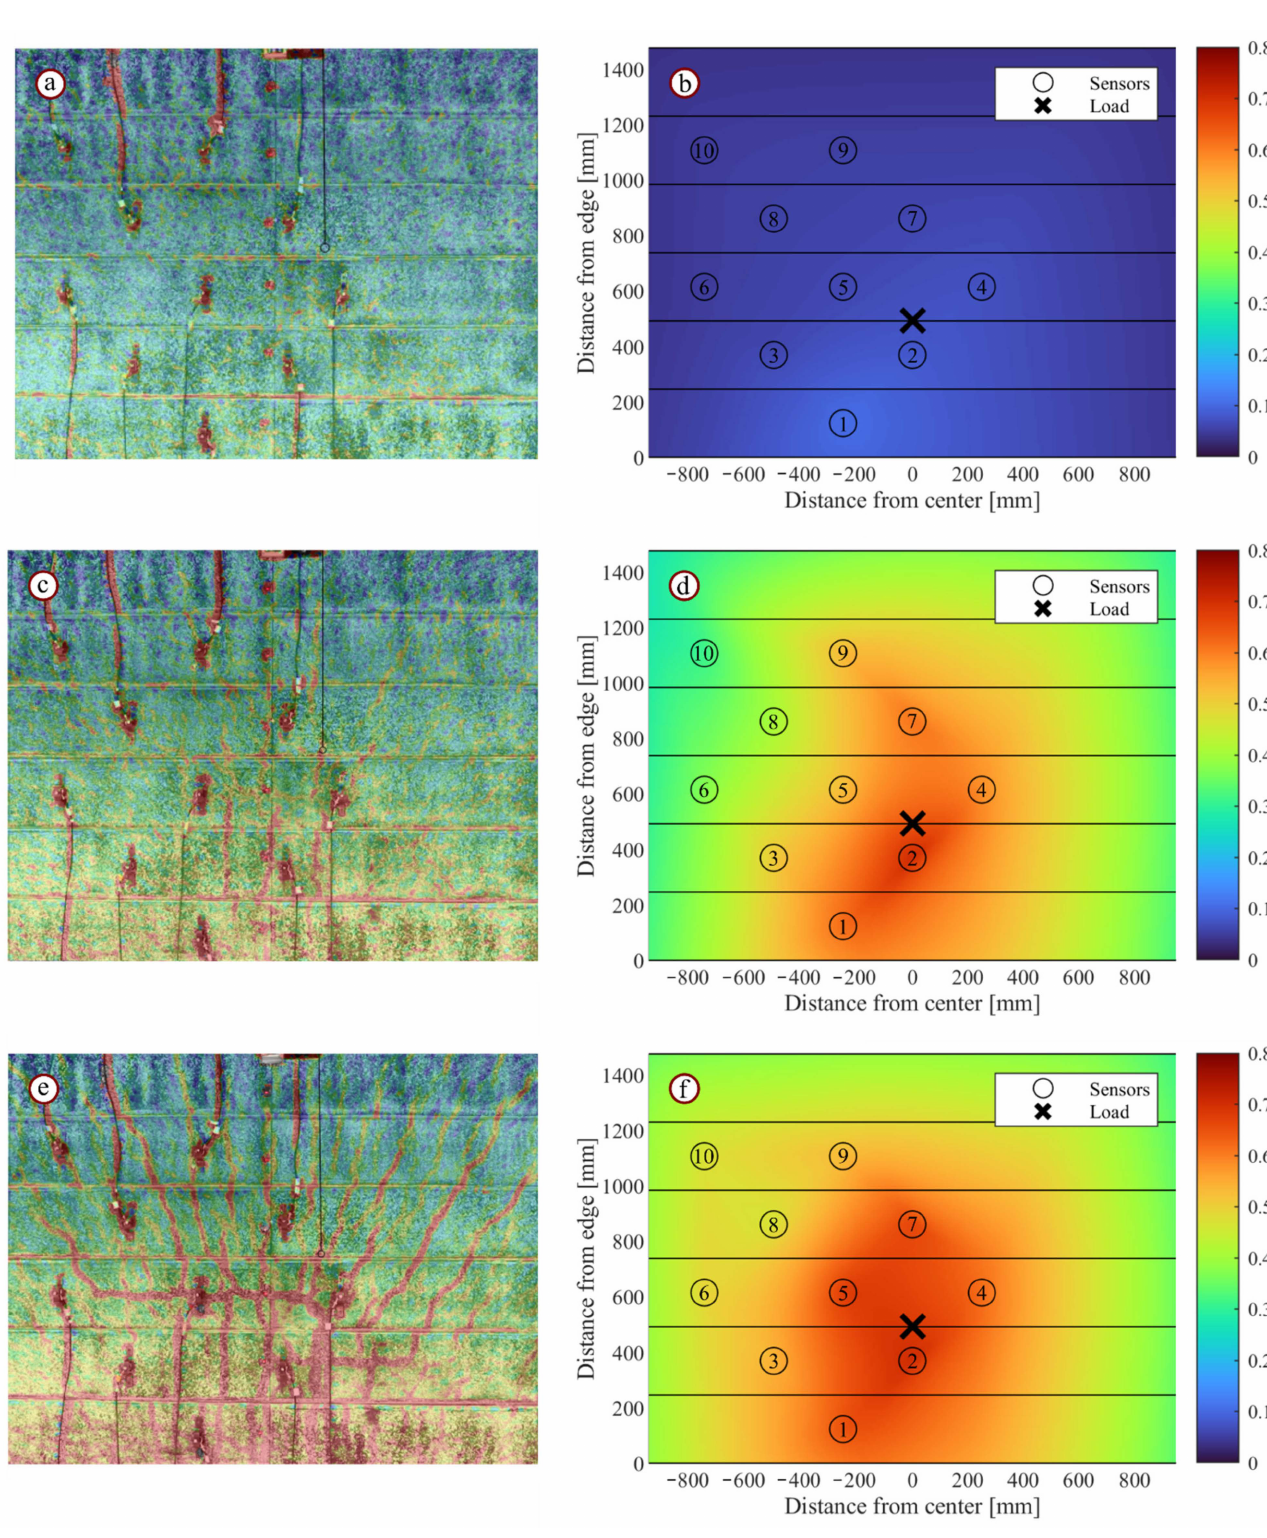
Figure 16. Crack pattern compared with surface plot of calm ratio at the third cycle of: ( a , b ) 300 kN, ( c , d ) 500 kN and ( e , f ) 700 kN. Only top sensors are included. Linear interpolation and zero-padding were applied to visualize the calm ratio surface plot; hence, only the contour within the confines of the sensor group is fully